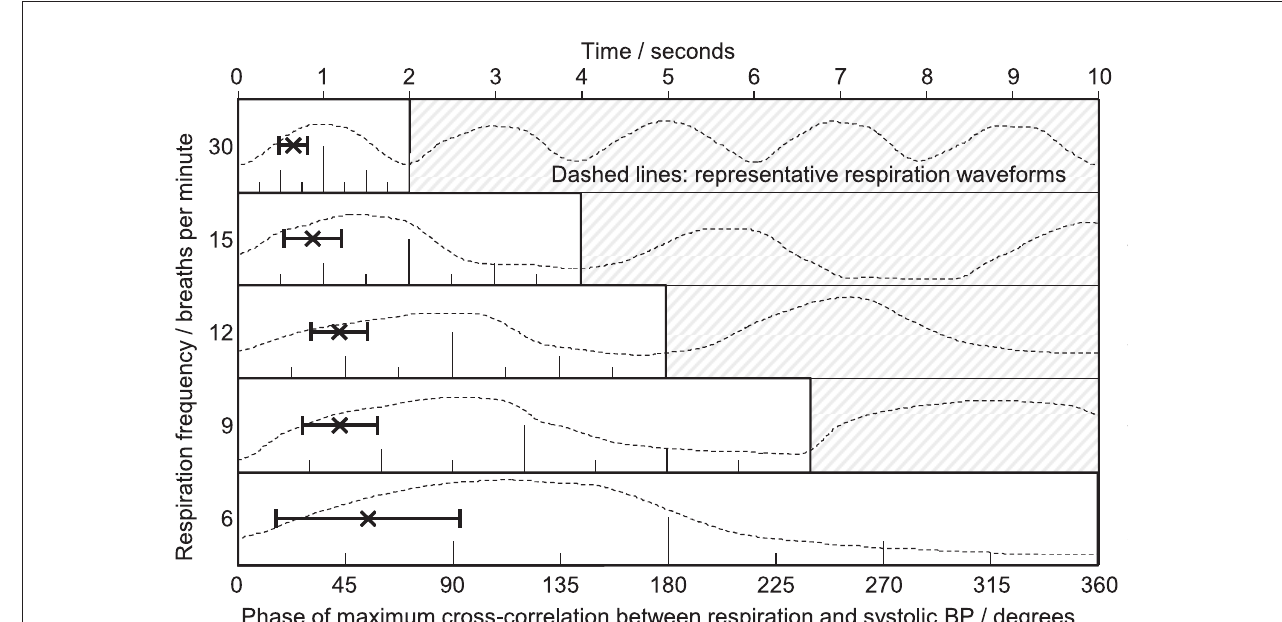
seconds (top scale) or relative lag in degrees of one full cycle (individual scales). BP fluctuations lagged behind respiration at all respiratory rates. The mean lag decreased slightly in absolute terms from 1.5s at the slowest rate of 6breaths per min to 0.65s at the fastest rate of 30breaths per min. As proportions of the respiratory cycle, the lags increased from 55 to 116 ◦ ,